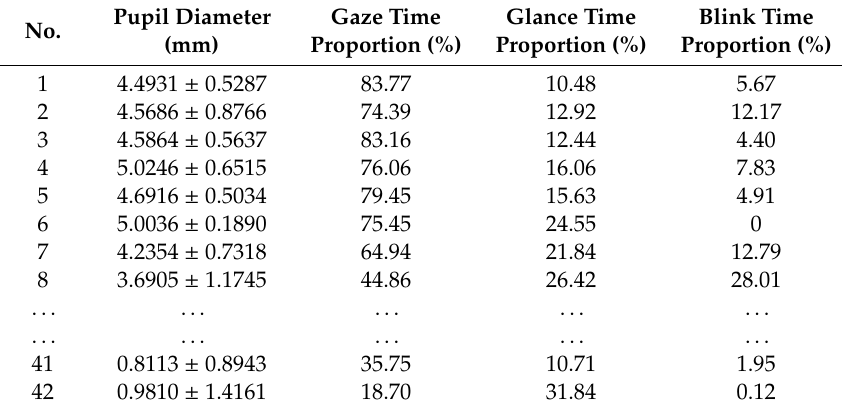
Table 5. PFs’ raw eye movement data after encountering di ff erent failures.